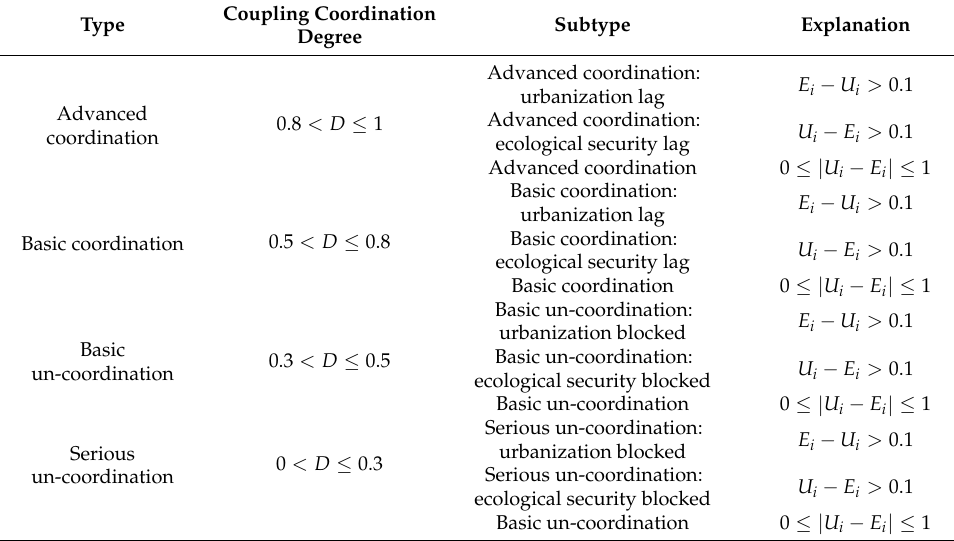
Table 4. Classification of coupling coordination degree of urbanization and ecological